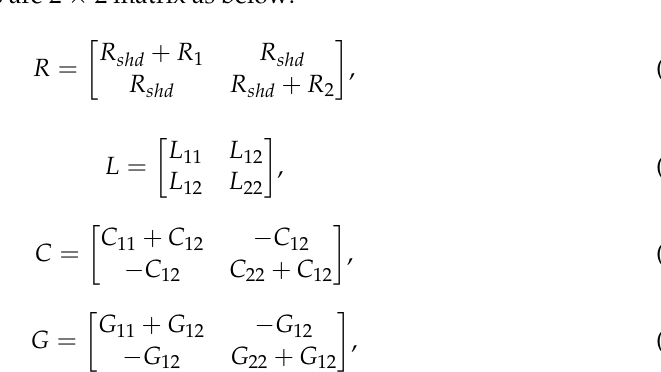
The cross-section of the antenna is shown in Figure 3. c 1 and c 2 are twisted wires of the helix coil sensors with radius of r c . The dielectric constant of materials from cable jacket to shielding layers are ε SEA , ε PE , ε INSUL , respectively. to shielding layers are ε SEA , ε PE , ε INSUL , respectively.